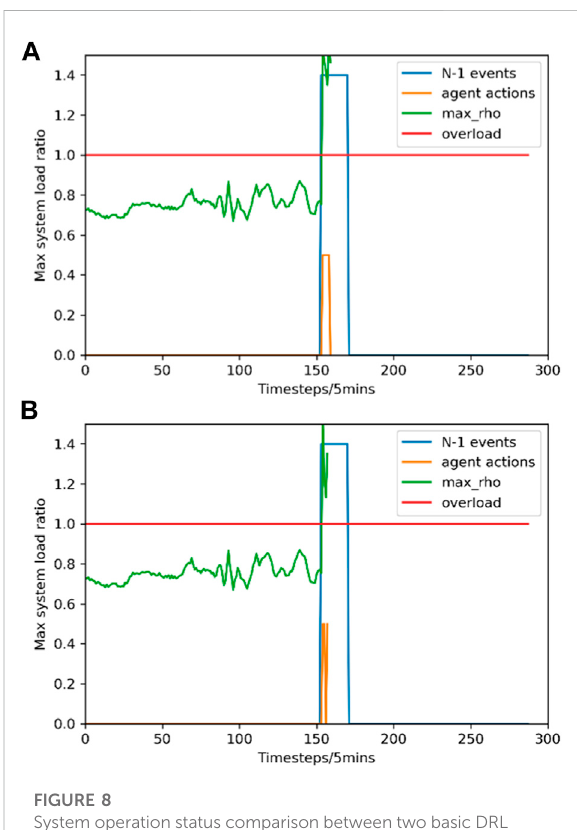
FIGURE 8 System operation status comparison between two basic DRL